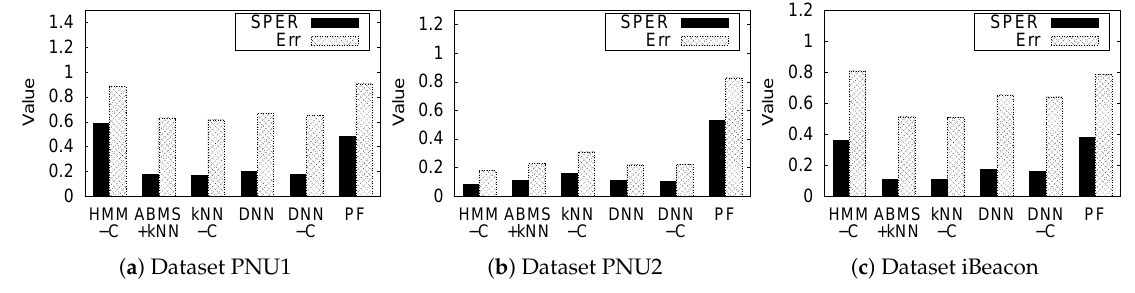
Figure 13. Comparison of SPER and error for each